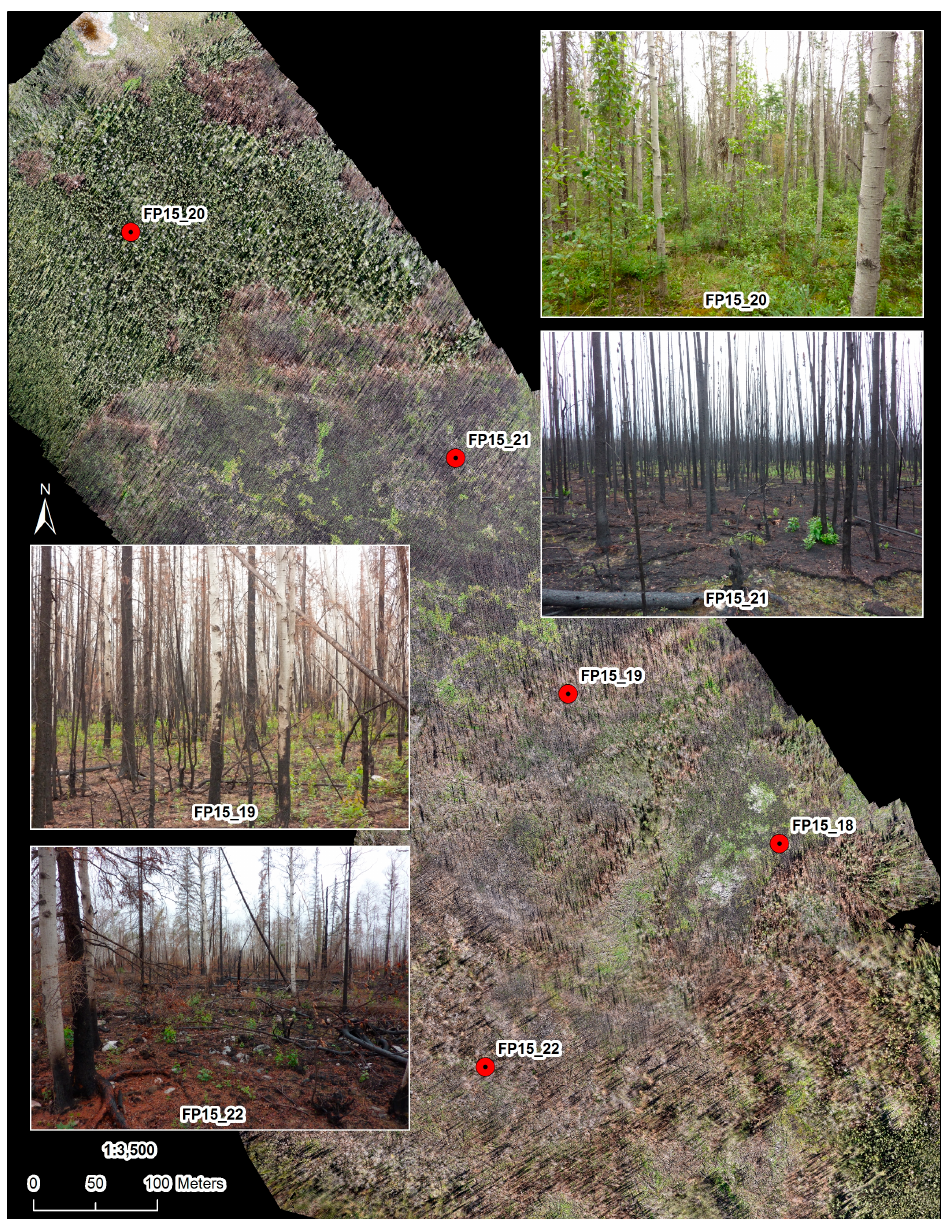
Figure 6. Portion of the UAV orthmosaic for study area #1 (centered at 69.905° N, 116.53° W), showing the locations of four CBI plots with corresponding inset ground photos.